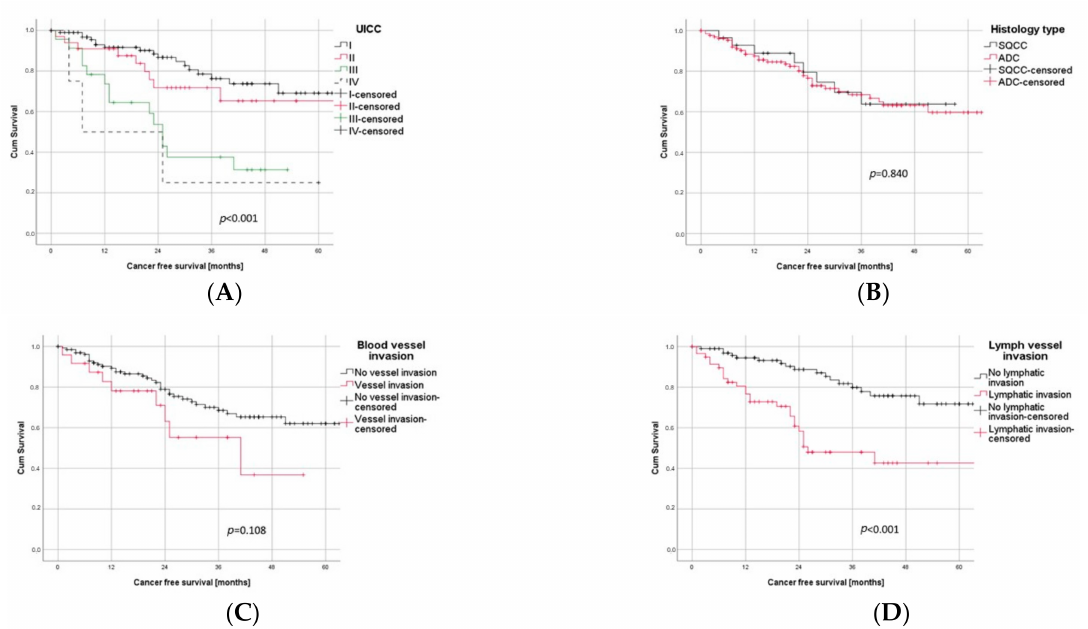
Figure 2. Prognostic Factors in Univariate Survival Analysis. ( A ) Survival differences between the four UICC stages (log rank test: p < 0.001). Stage III and IV were combined, both separately being under-represented due to the inclusion criteria of minimally invasive surgery. ( B ) Histological subtype did not significantly correlate with survival (log rank test: p = 0.840). ( C ) BVI showed a tendency to being negative prognostic but missed level of significance (log rank test: p = 0.108). ( D ) LVI was significantly (log rank test: p < 0.001) associated with worse outcome.